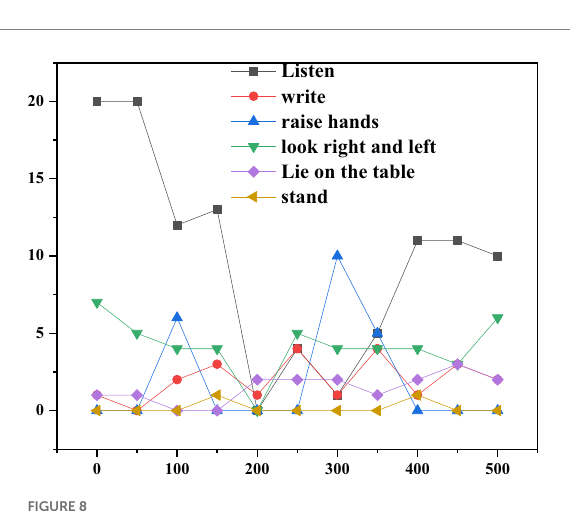
FIGURE 8 Statistics of the number of behaviors in the class.